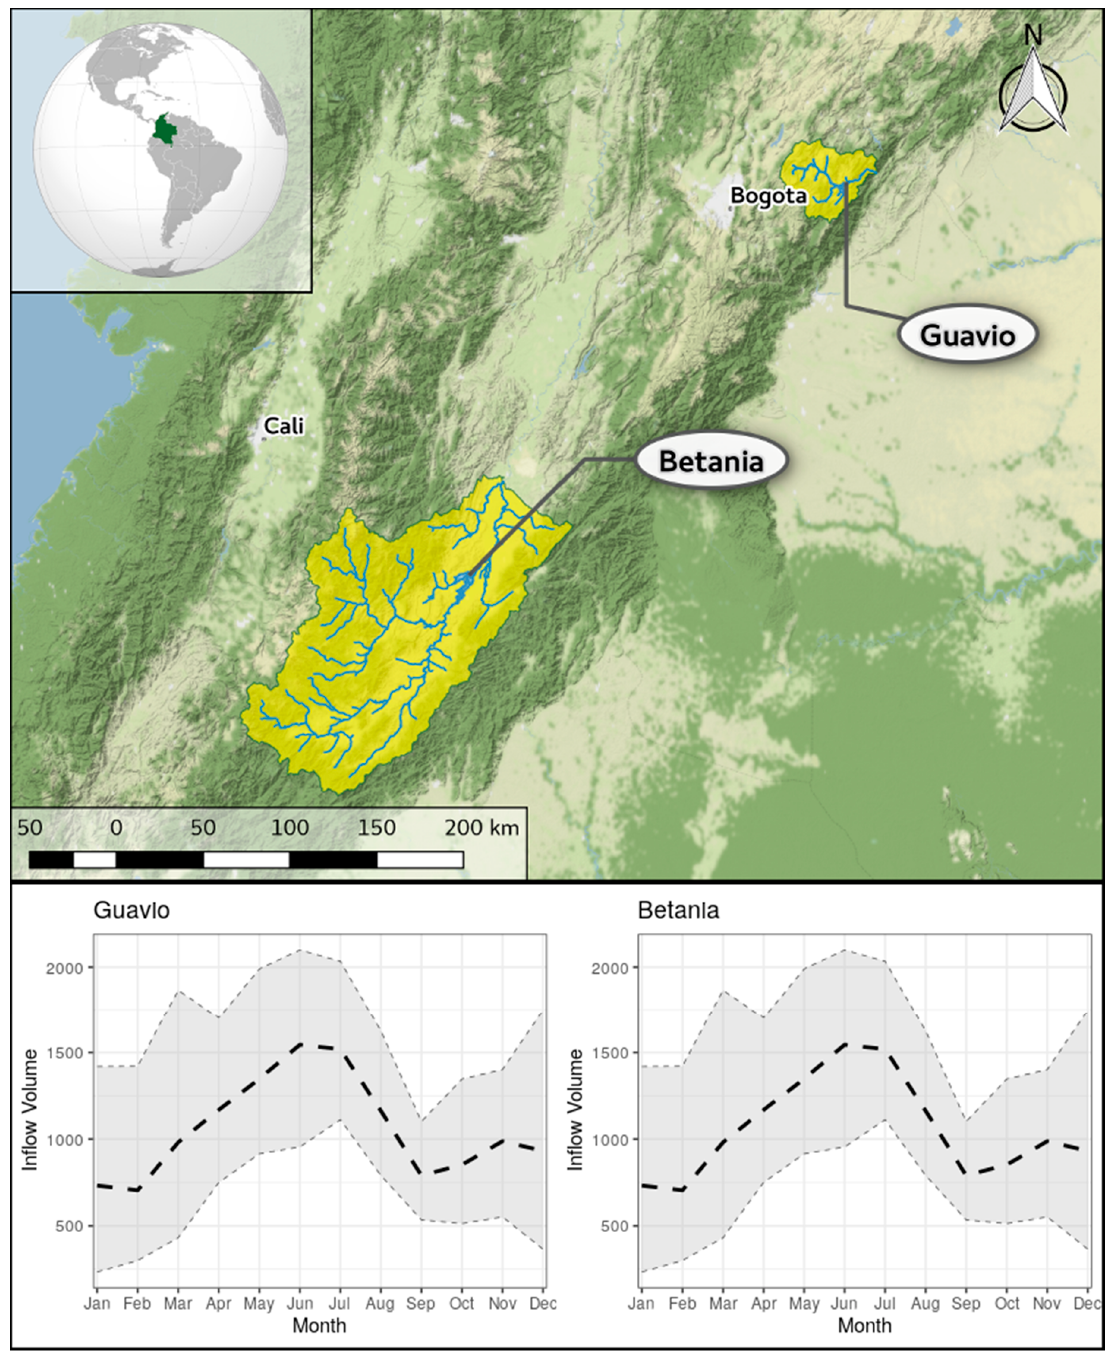
Figure 1. Case study area and monthly reservoir river discharge, in Mm³, to the Guavio and Betania hydropower plants. The climatological average is highlighted as the black dashed line, while the monthly maximum and minimum values for each month during the period 1993–2019 are shown as the grey ribbon area.